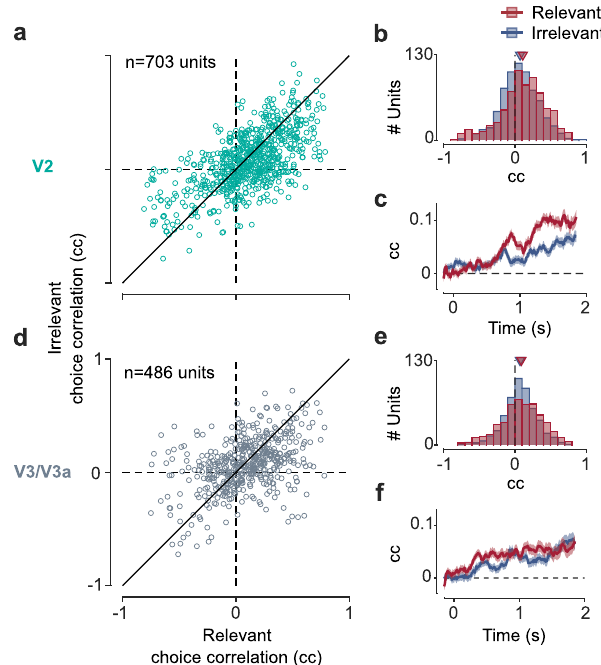
Fig. 2 Neurons representing the task-irrelevant stimulus are correlated with choice. a Choice correlations (cc) for n = 703 units in V2 when the stimulus in the receptive fi eld was relevant (abscissa) or irrelevant (ordinate) are correlated ( r = 0.61, p = 10 − 71 , two-sided Spearman ’ s rank correlation). b Choice correlations for both the relevant (red, mean = 0.11 (area under the receiver-operating characteristic, aROC = 0.55), p = 10 − 21 )) and irrelevant (blue, mean = 0.07 (aROC = 0.53), p = 10 − 12 , two-sided Wilcoxon signed rank) stimulus were signi fi cantly positive and similar although their distributions differed signi fi cantly from one another (two-sided Wilcoxon signed rank, p = 10 − 4 ). c Choice correlation (300ms wide sliding window, 10ms increment) as a function of time after stimulus onset for the relevant (red) and irrelevant (blue) stimulus. Error bars depict s.e.m. d – f Same as a – c but for n = 486 units in V3/V3a (correlation between relevant and irrelevant choice correlations r = 0.42, p = 10 − 21 ; relevant: mean = 0.09 (aROC = 0.54), p = 10 − 10 ; irrelevant: mean = 0.07 (aROC = 0.53), p = 10 − 12 ; difference in distributions, p =